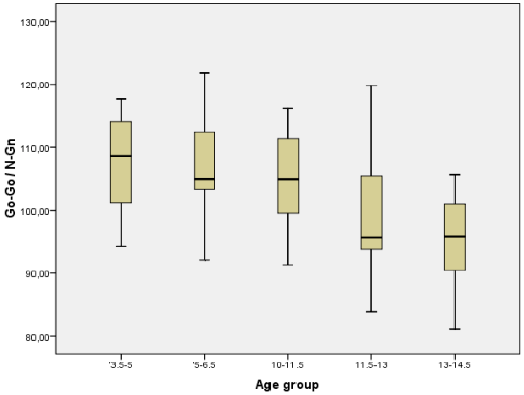
Figure 10. Boxplot for Go-Go/N-Gn values.